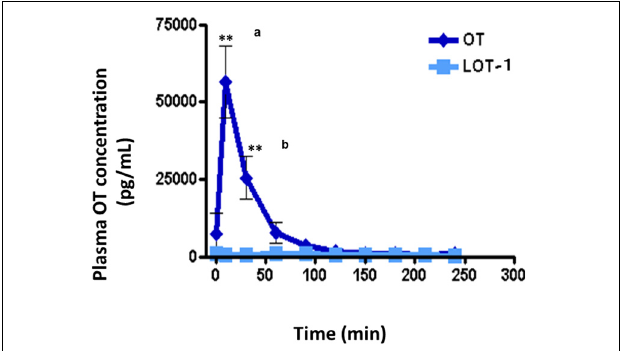
FIGURE 5 | Plasma levels of oxytocin (OT) in adult males after oral administration of lipo-oxytocin 1 (LOT-1). Blood samples were collected from the hearts of adult males after oral administration of OT or LOT-1 (each 10 µ g × 100 µ L). Significant differences between OT and LOT-1 ( a P < 0.001, b P < 0.01). Significantly different from the control value at ** P < 0.001. n = 3–8. Experiments were performed according to figure by Higashida et al.